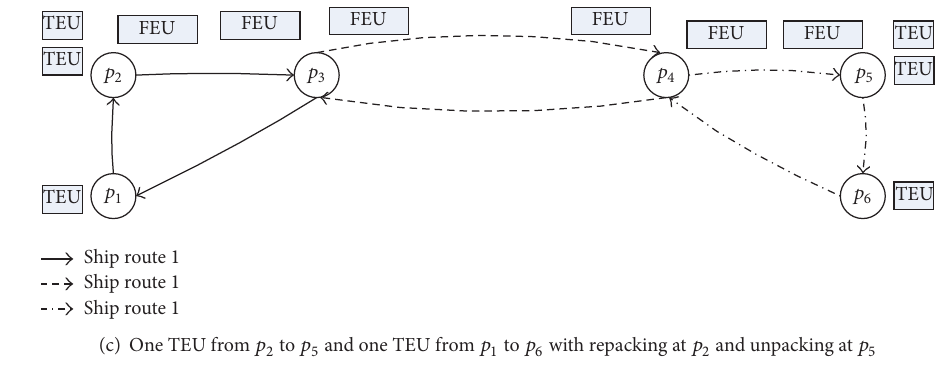
Figure 3: Container packing with different origins and